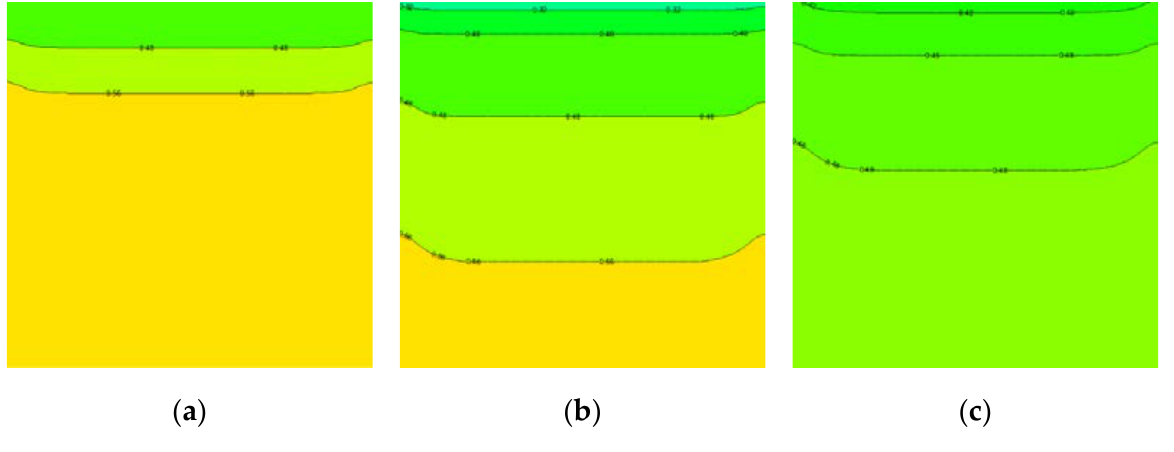
Figure 11. Remaining oil distribution of each layer after water flooding stage of Figure 2: ( a ) low- permeability layer, ( b ) medium-permeability layer, ( c ) high-permeability layer .